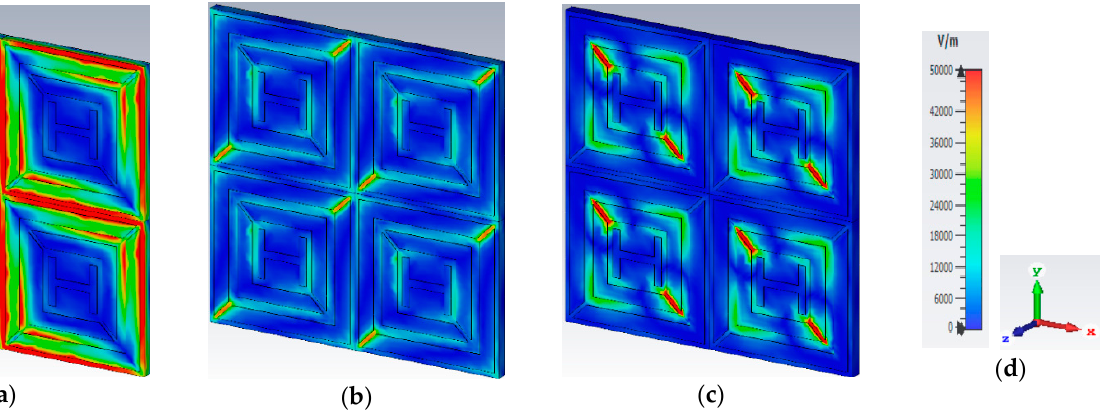
Figure 7. Electric field at ( a ) 6.24 GHz; ( b ) 10.608 GHz; ( c ) 18.624 GHz. ( d ) Scale and axis.